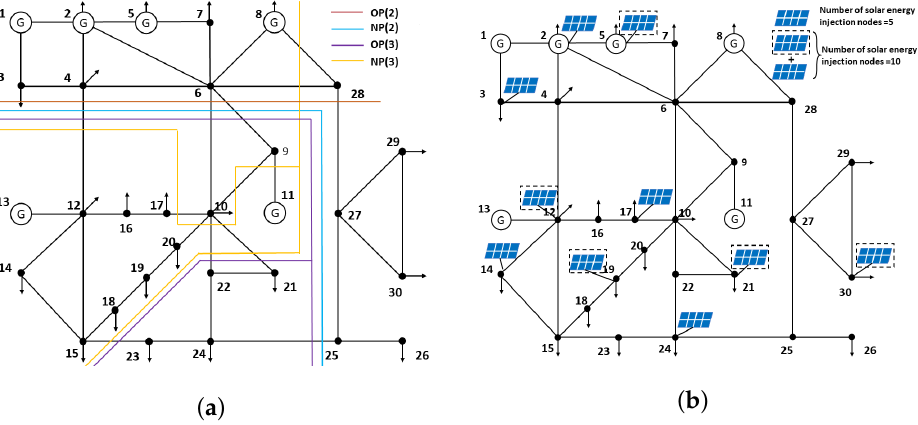
Figure 1. Test case for the IEEE 30-bus system. ( a ) Area partitioning cases; ( b ) Solar energy injection. (NP(2) and NP(3) are from